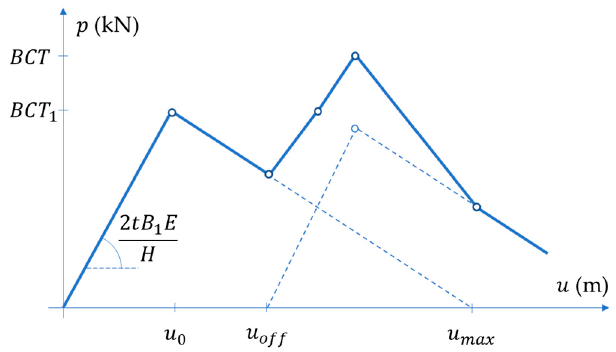
Figure 8. Force-displacement visualization of the proposed method.